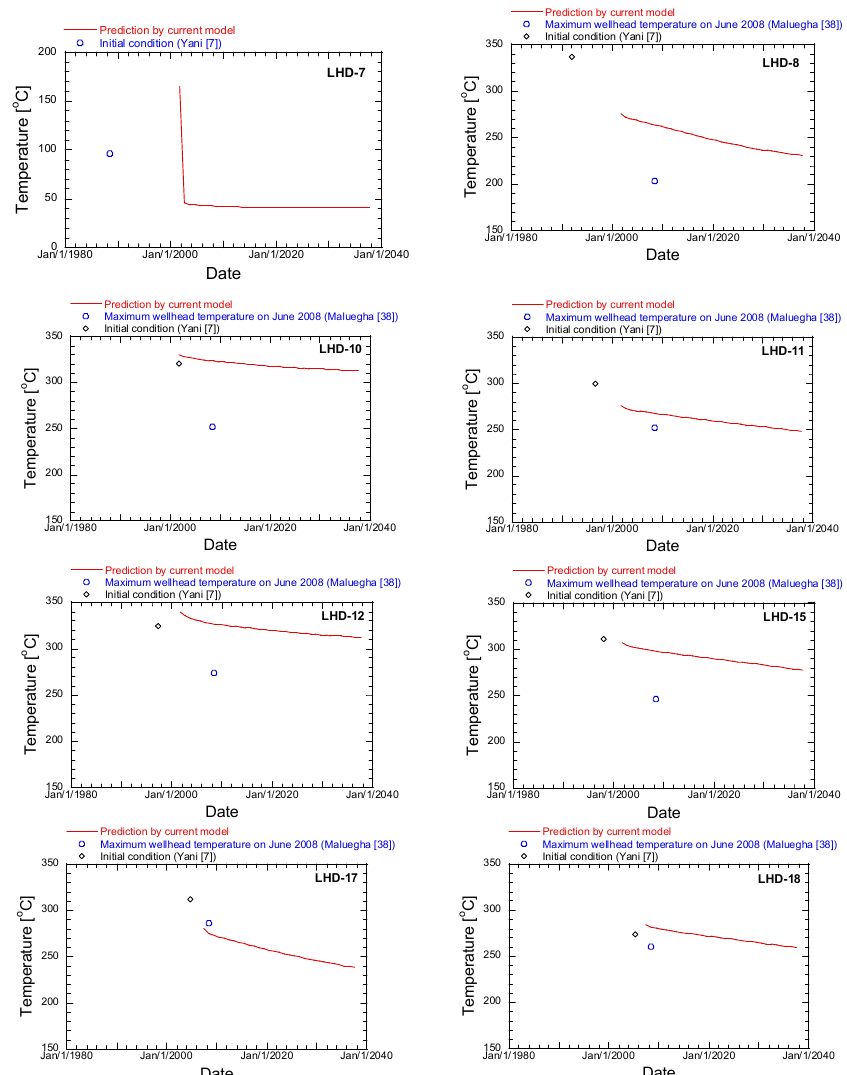
Figure 19. Comparison of reservoir temperatures among initial condition, wellhead temperature, and prediction by the current model.